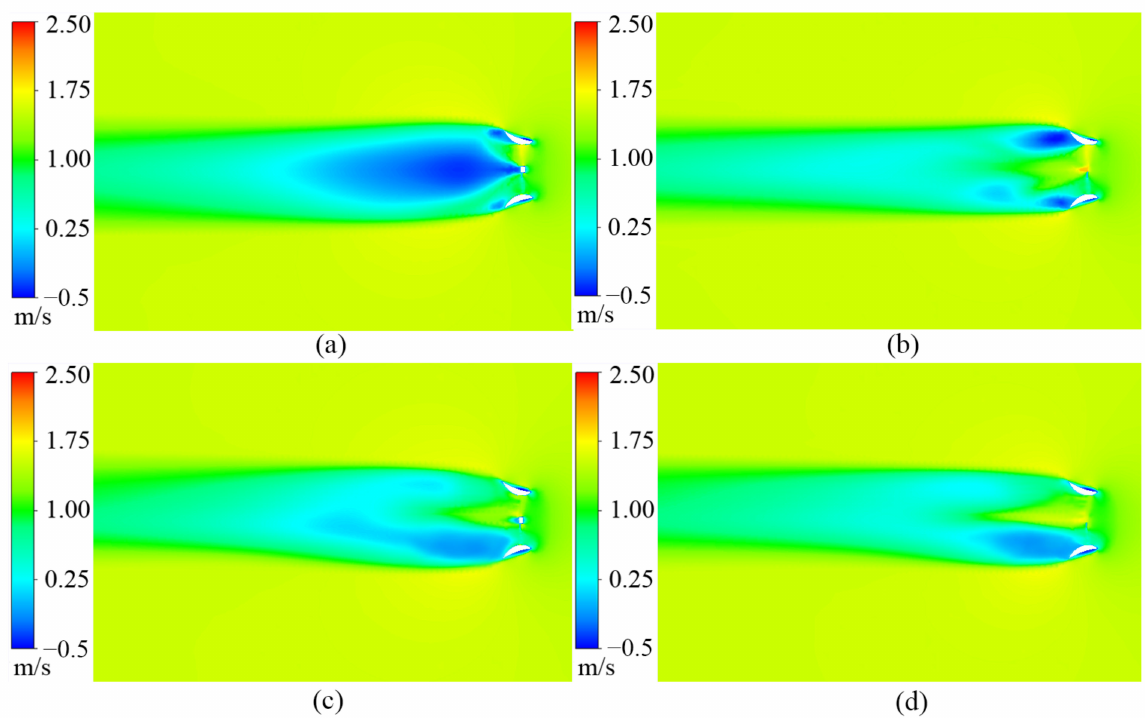
Figure 9. Axial velocity distribution comparison between the DT and the SDT: ( a ) DT at TSR = 4.0; ( b ) SDT at TSR = 4.0; ( c ) DT at TSR = 6.0; ( d ) SDT at TSR = 6.0.